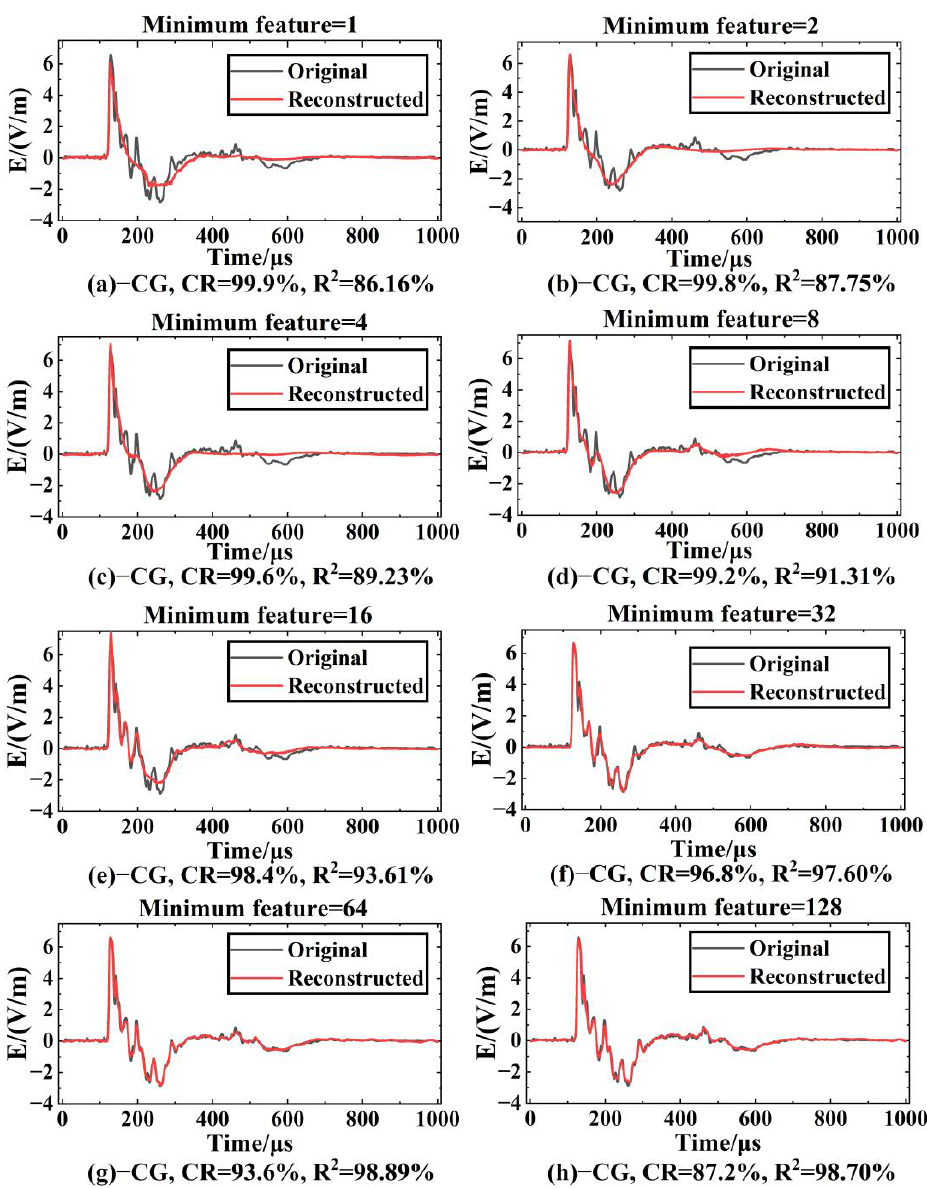
Figure 9. Comparison of original and reconstructed waveforms of − CG under different CR s.